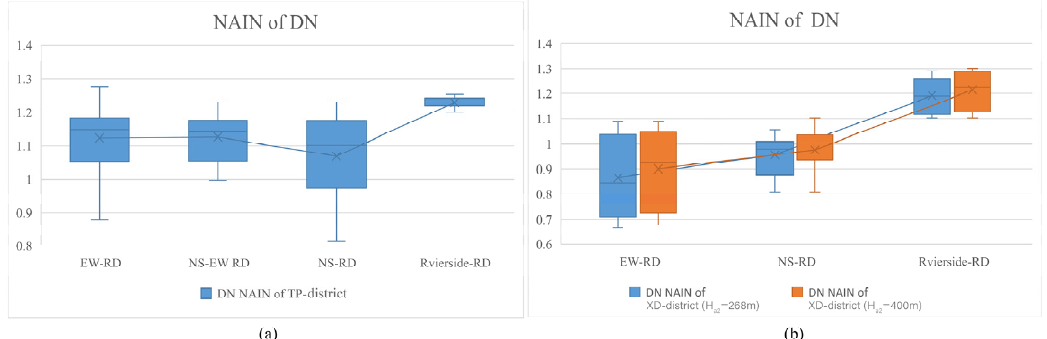
Figure 15. Boxplot analysis of NAIN values for various types of decision nodes. ( a ) TP-District; ( b ) XD-District. Table 3. Standard deviation of NAIN values for each type of node.